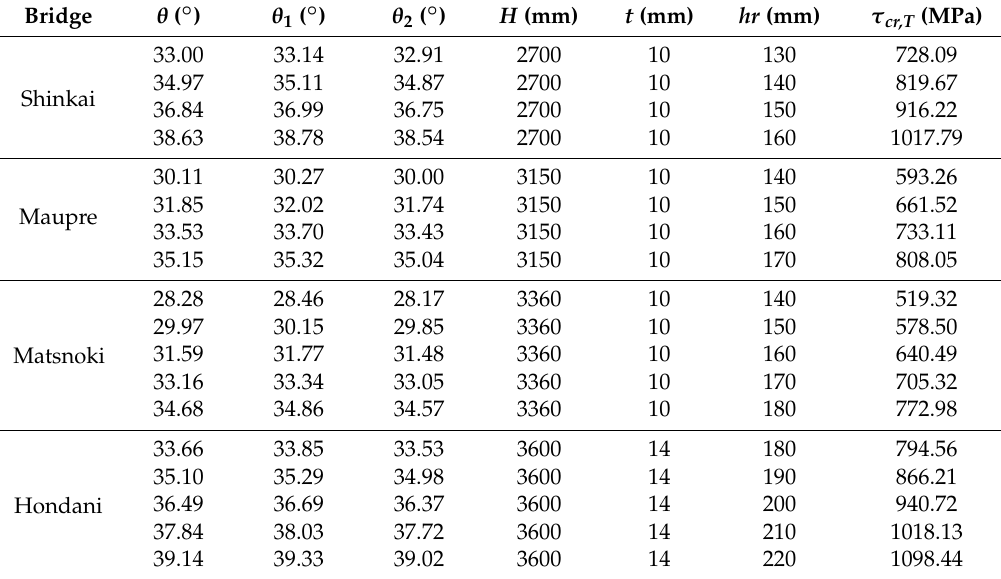
Table 6. Global elastic shear buckling strength of PCCSW with different angles and corrugation heights for R = 110